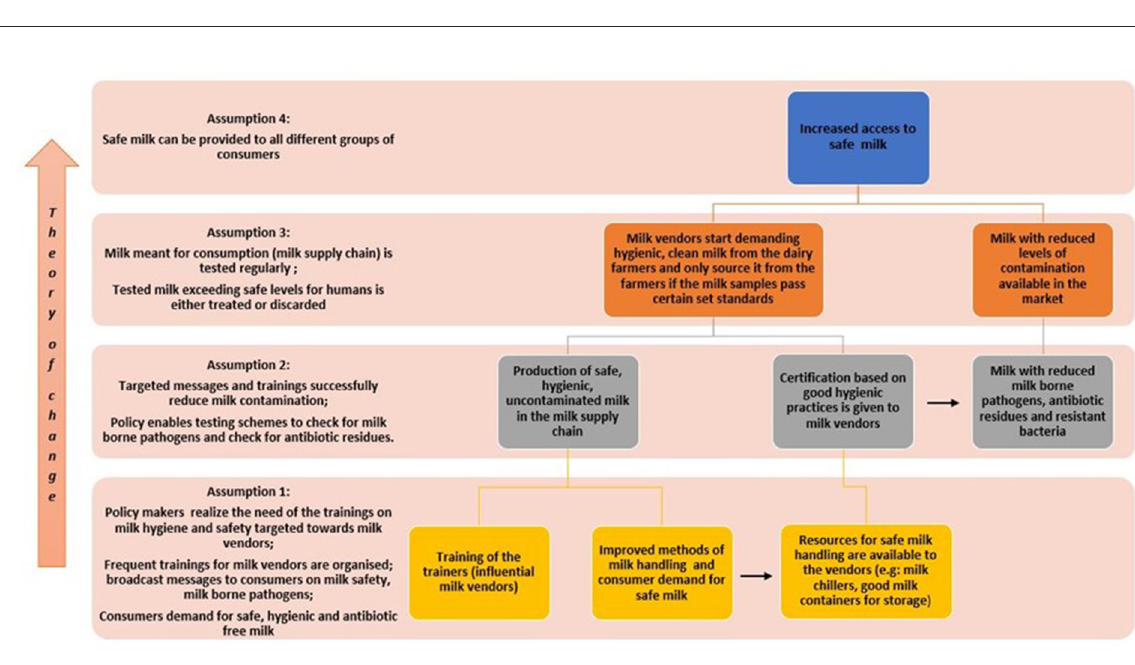
that milk vendors have so limited awareness of antibiotics while yet being found to be giving antibiotics to dairy farmers raises serious